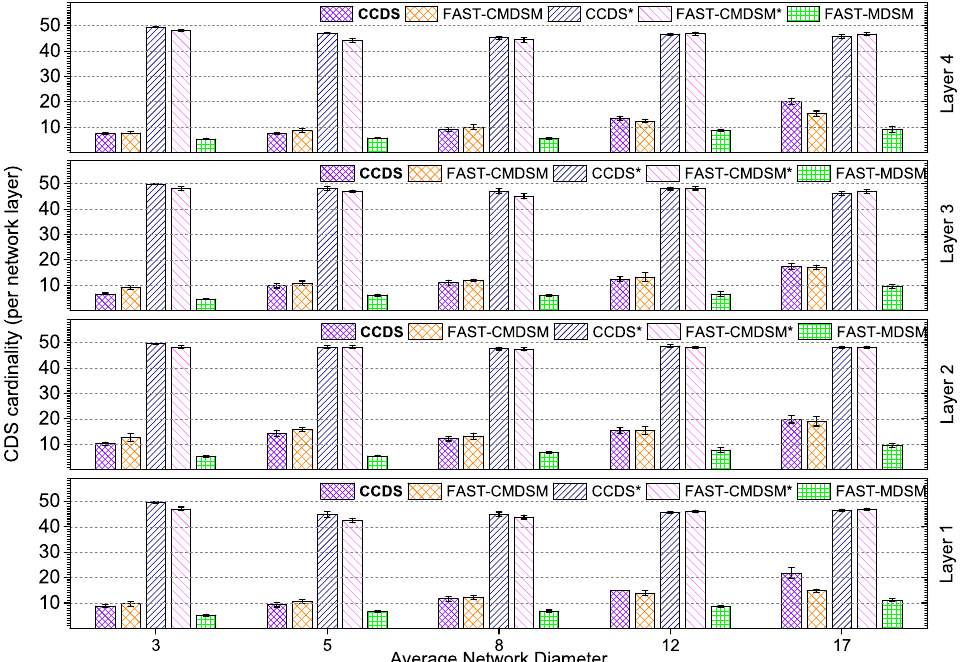
Figure 6. Impact of network diameter (Medium skewness).